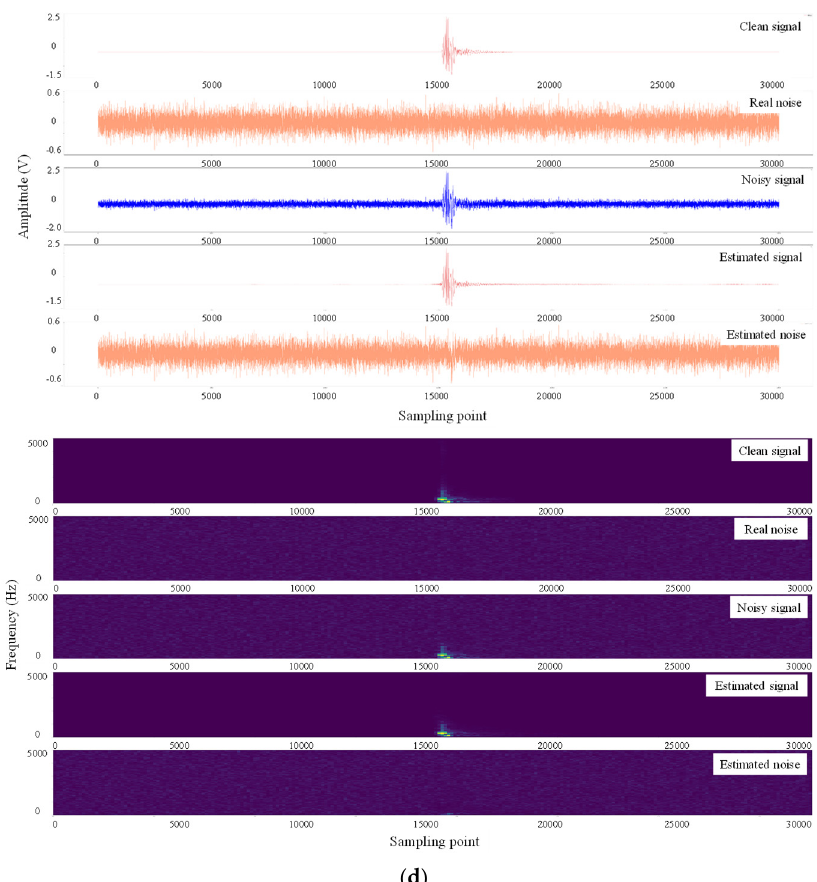
Figure 3. Denoising performance of CNN-denoiser for noisy signals with various noise in the test dataset. The signals in the time domain and time–frequency domain for each sub-figure are clean signal, real noise, noisy signal, estimated signal, and estimated noise from top to bottom. ( a , b ) Microseismic signals with cyclic noises at different frequency; ( c ) microseismic signals with a mixture of cyclic noise and other noise; ( d ) microseismic signals with Gaussian noise.